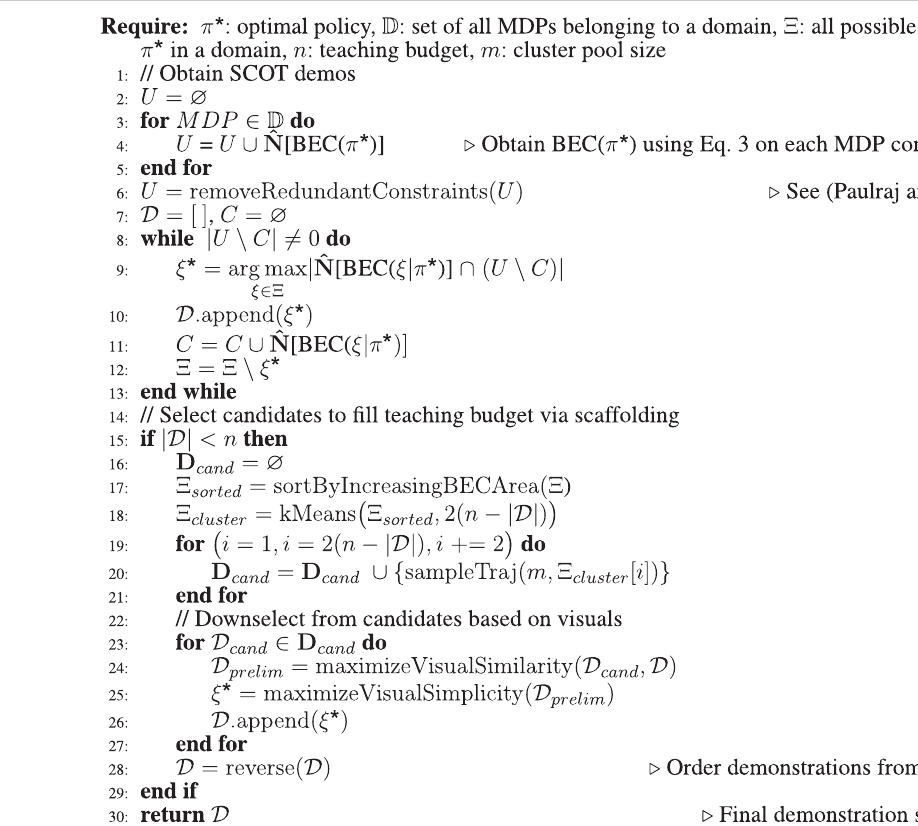
Algorithm 1 Machine Teaching for Human